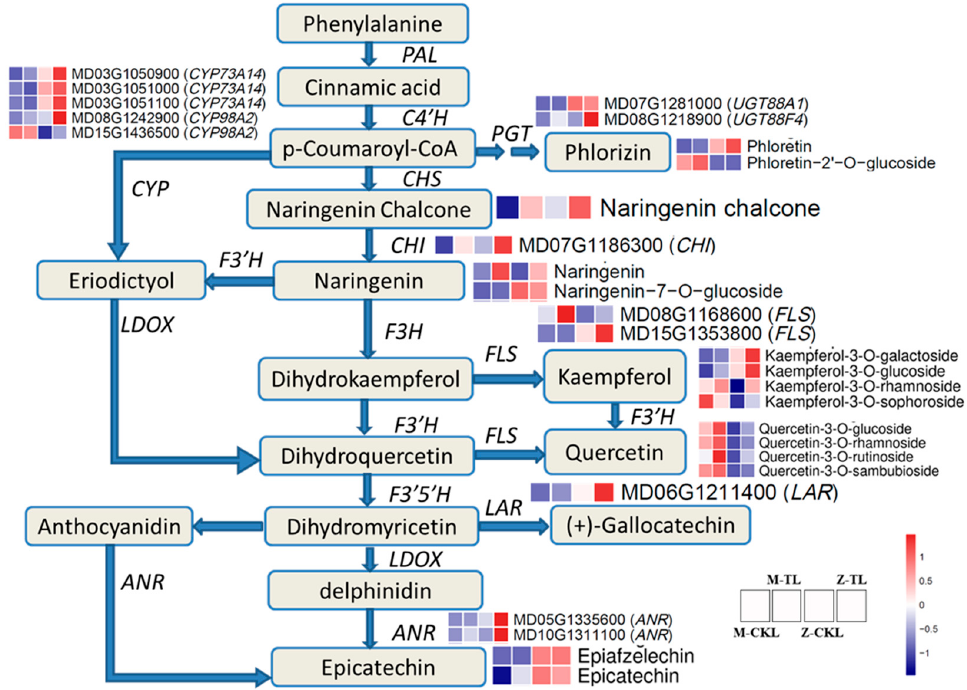
Figure 10. The main salt-tolerance genes and metabolites in phenylpropanoid biosynthesis pathway (PAL, phenylalanine ammonia-lyase; C4 ′ H, cinnamate-4 ′ -hydroxylase; CYP, cytochrome P450; PGT, phydroxybenzoate geranyltransferases; CHS, chalcone synthase; CHI, chalcone isomerase; F3 ′ H, flavonoid-3 ′ -hydroxylase; F3H, flavonoid-3-hydroxylase; LDOX, leucoanthocyanidin dioxygenase; FLS,flavonol synthase; F3 ′ 5 ′ H, flavonoid-3 ′ ,5 ′ -hydroxylase; LAR, leucoanthocyantin reductase; ANR, anthocyanidin synthase).